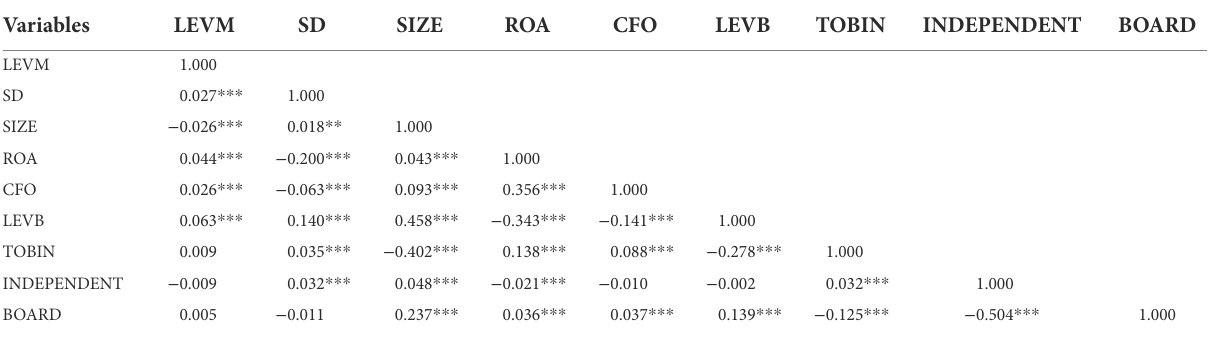
TABLE 3 Coefficient correlation